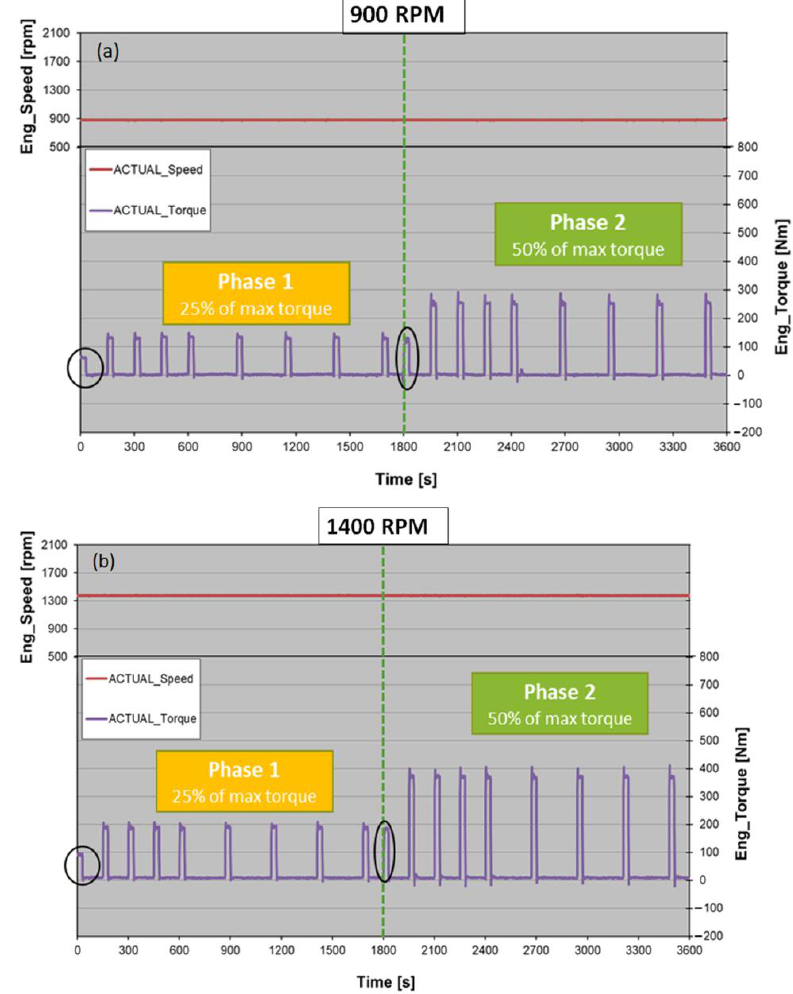
Figure 7. The 900 rpm ( a ) and 1400 rpm ( b ) tests with torque variation over time. The black high-lighted steps refer to the pre-conditioning sections. The green dashed line divides phase 1 from phase 2. Table 10. The CPF test characteristics valid for both 900 and 1400 rpm.